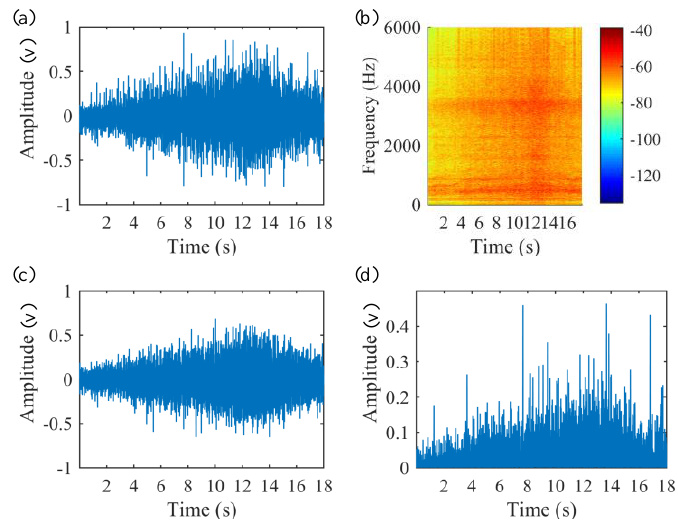
Figure 12. ( a ) Raw vibration signal from bearing with a local inner race fault, ( b ) TFR of the raw vibration signal, ( c ) lower frequency band signal, and ( d ) envelope of the resonant frequency band signal.